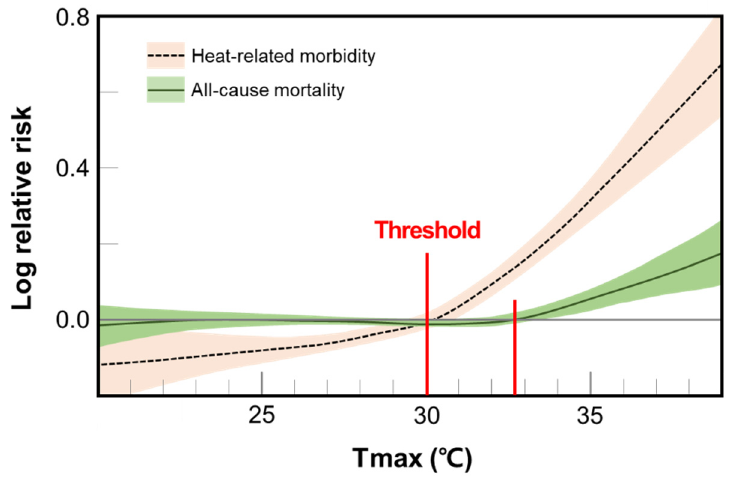
Figure 2. Association between daily maximum temperature (Tmax) and negative health outcomes (all-cause mortality and heat-related morbidity).